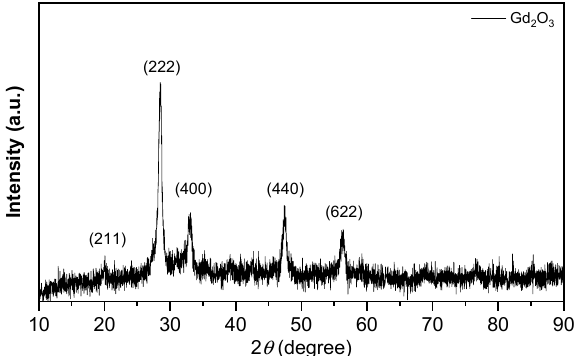
Figure 1. XRD pattern of the synthesized Gd 2 O 3